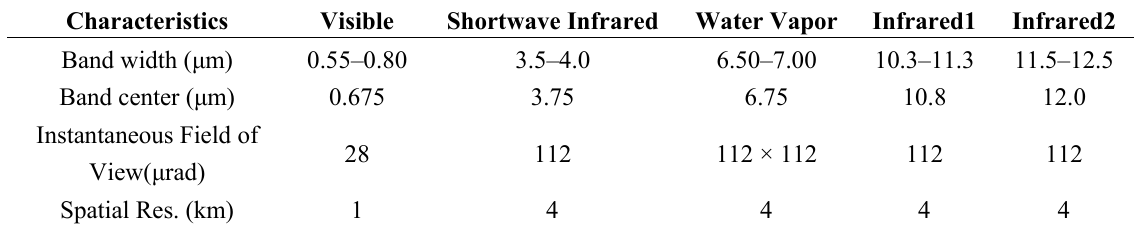
Table 1. Summary of Communication, Ocean and Meteorological Satellite (COMS) meteorological imager used in this